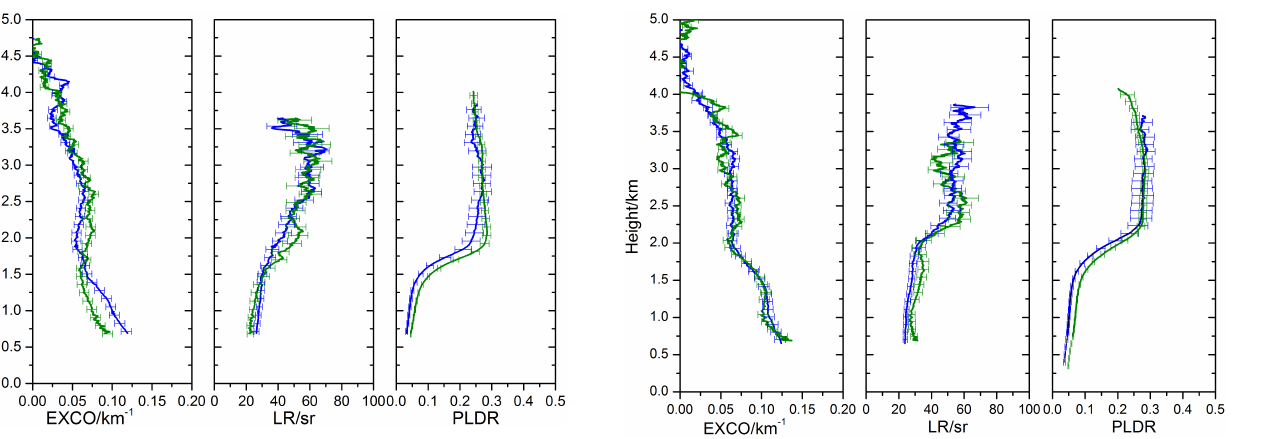
Figure 9. Same as Fig. 5 but for 1 July 2013, 07:00–08:45UTC.